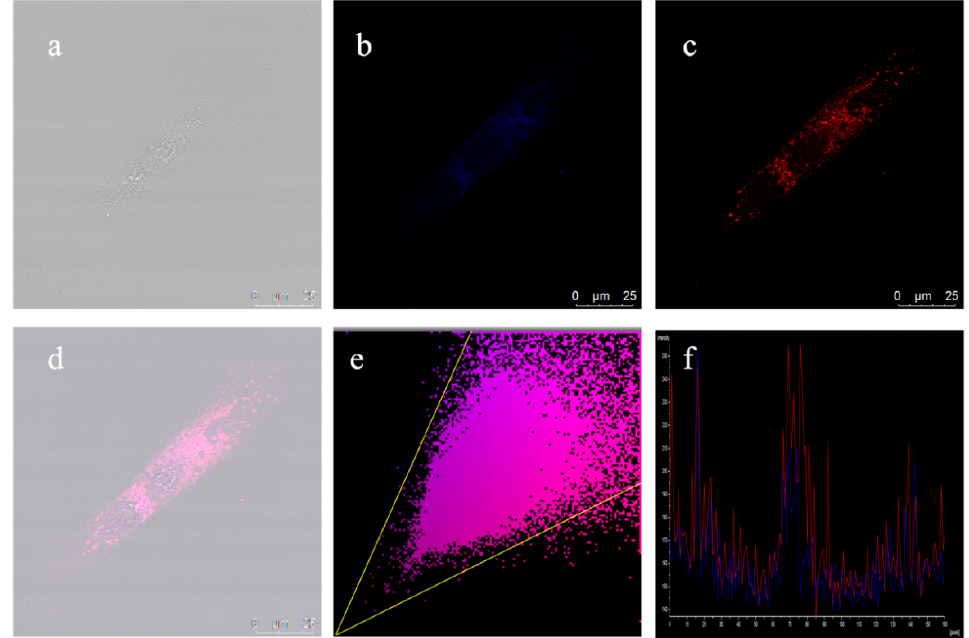
Figure 4. ( a ) Bright field images. ( b ) MMN( λ em = 415 nm). ( c ) Lyso-Tracker Red ( λ em = 577 nm). ( d ) Merge images of ( a – c ). ( e ) The intensity scatter plot of blue channel and red channel. ( f ) Intensity profile of ROI across the cells in the red and blue channels.